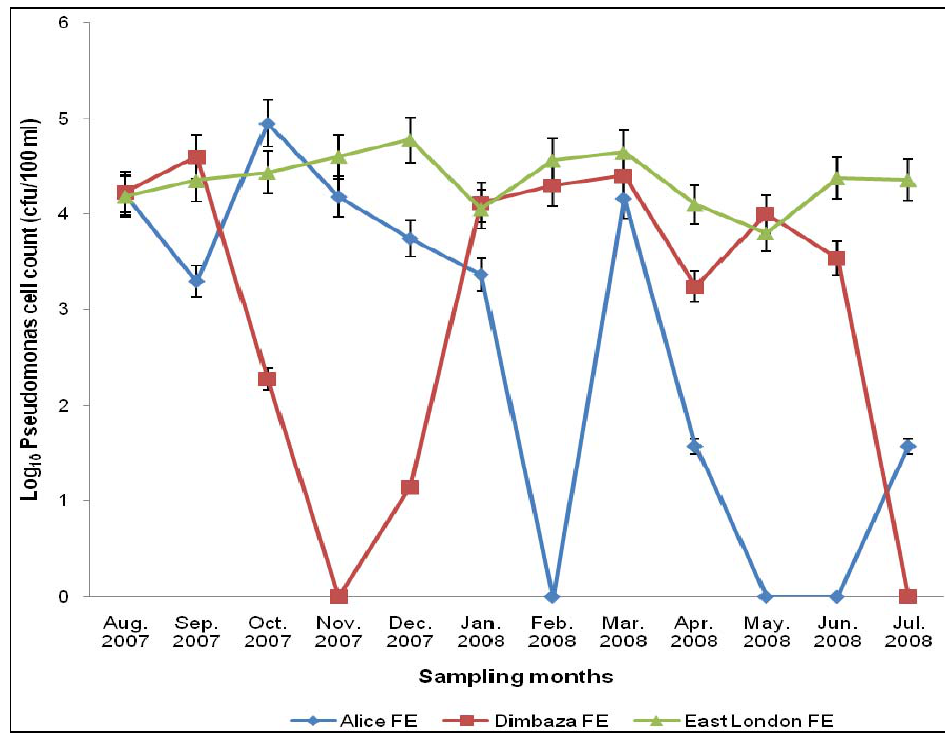
Figure 2. Total Pseudomonas count in the treated final